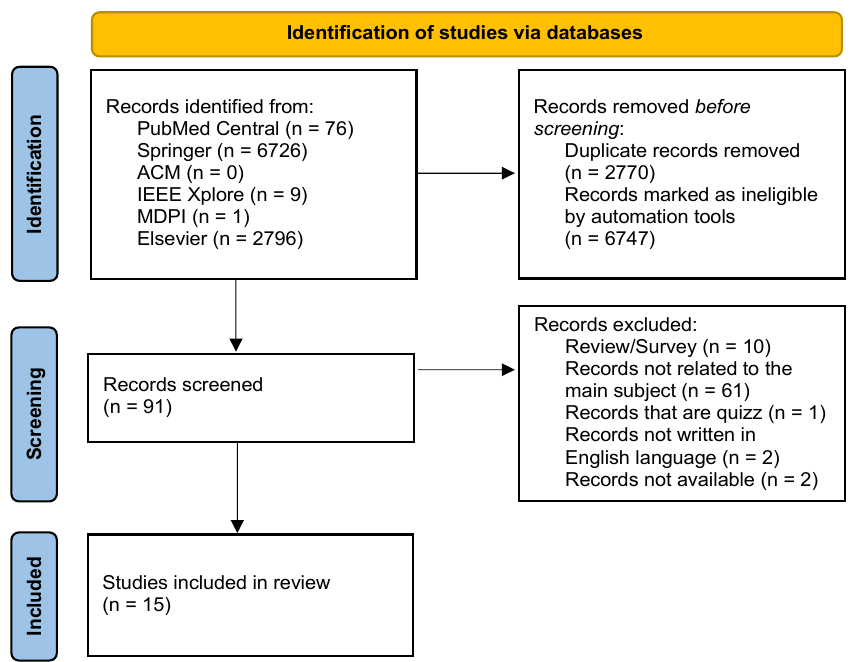
Figure 1. Flow diagram of identification and inclusion of papers.